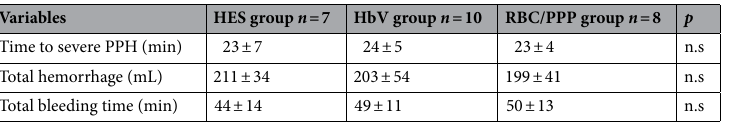
Table 3. Variables associated with hemorrhage. Data are expressed as the mean ± standard deviation. HbV hemoglobin vesicle, HES hydroxyethyl starch, n.s not significant, PPH postpartum hemorrhage, RBC/PPP red blood cells with platelet-poor